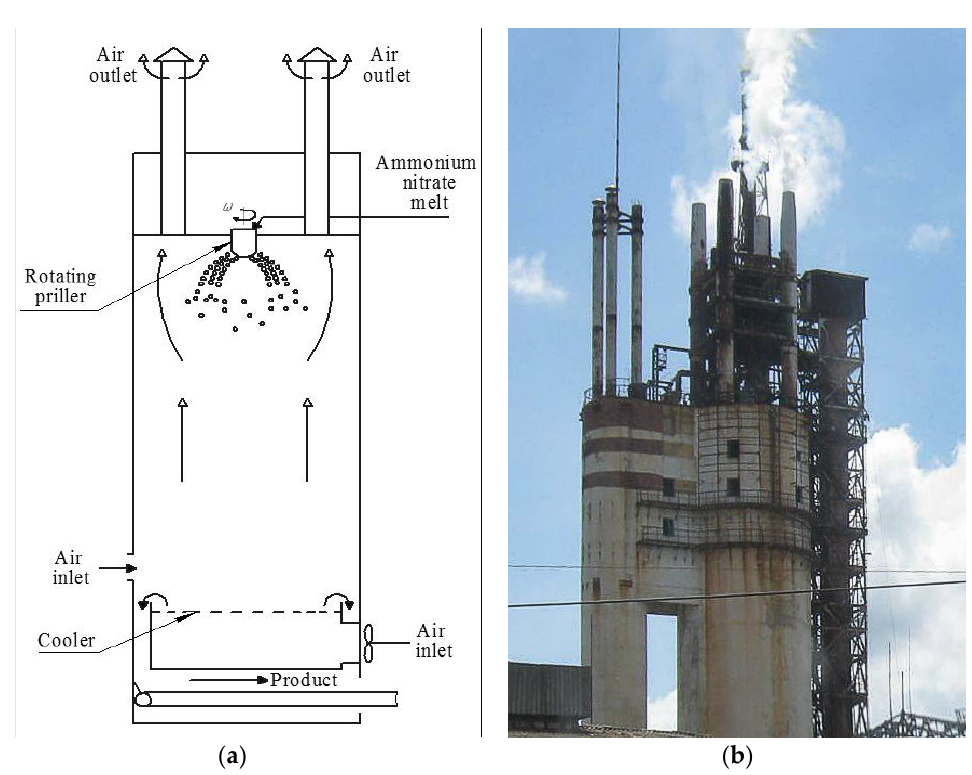
Figure 6. Prilling tower: ( a ) schematic diagram; ( b ) photo, side view of the prilling tower.